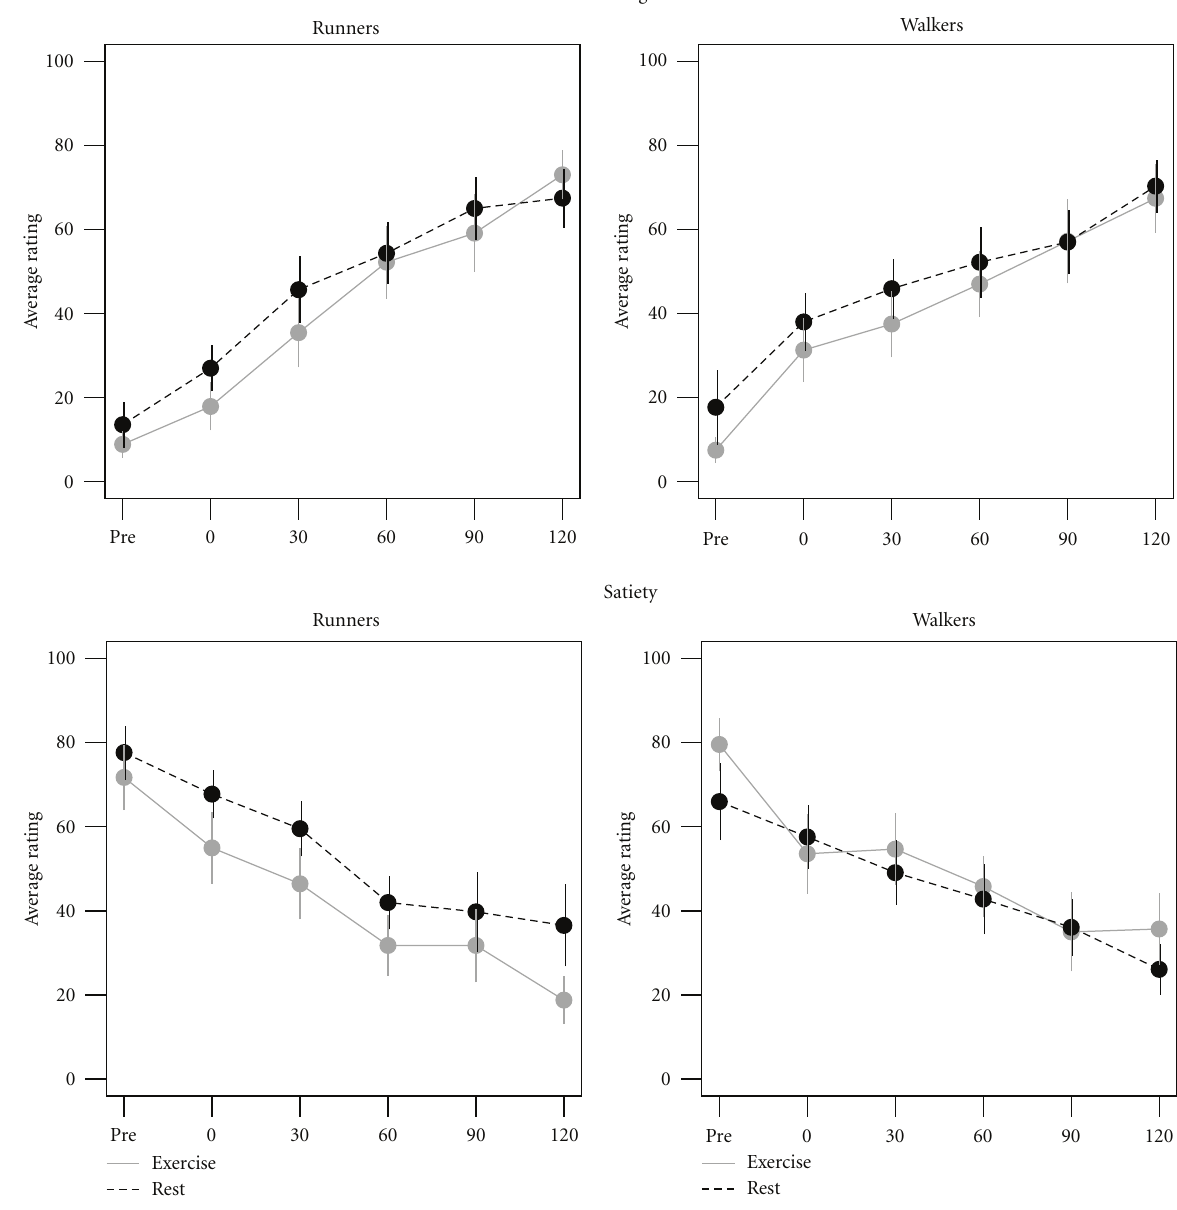
Figure 4: Average change in hunger (upper panel) and satiety (lower panel) for runners and walkers during exercise (solid grey) and rest (dashed black). “Pre” represents the time point just before exercise or rest. Vertical bars display the standard error of the mean for hunger and satiety at that time point. Data for fullness and desire to eat are not